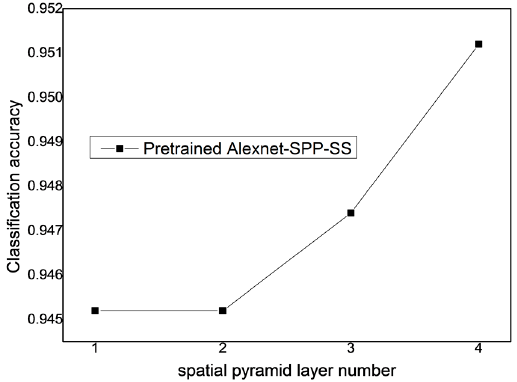
Figure 16. The influence of the spatial pyramid number for the pre-trained AlexNet-SPP-SS model with the WHU-RS dataset.